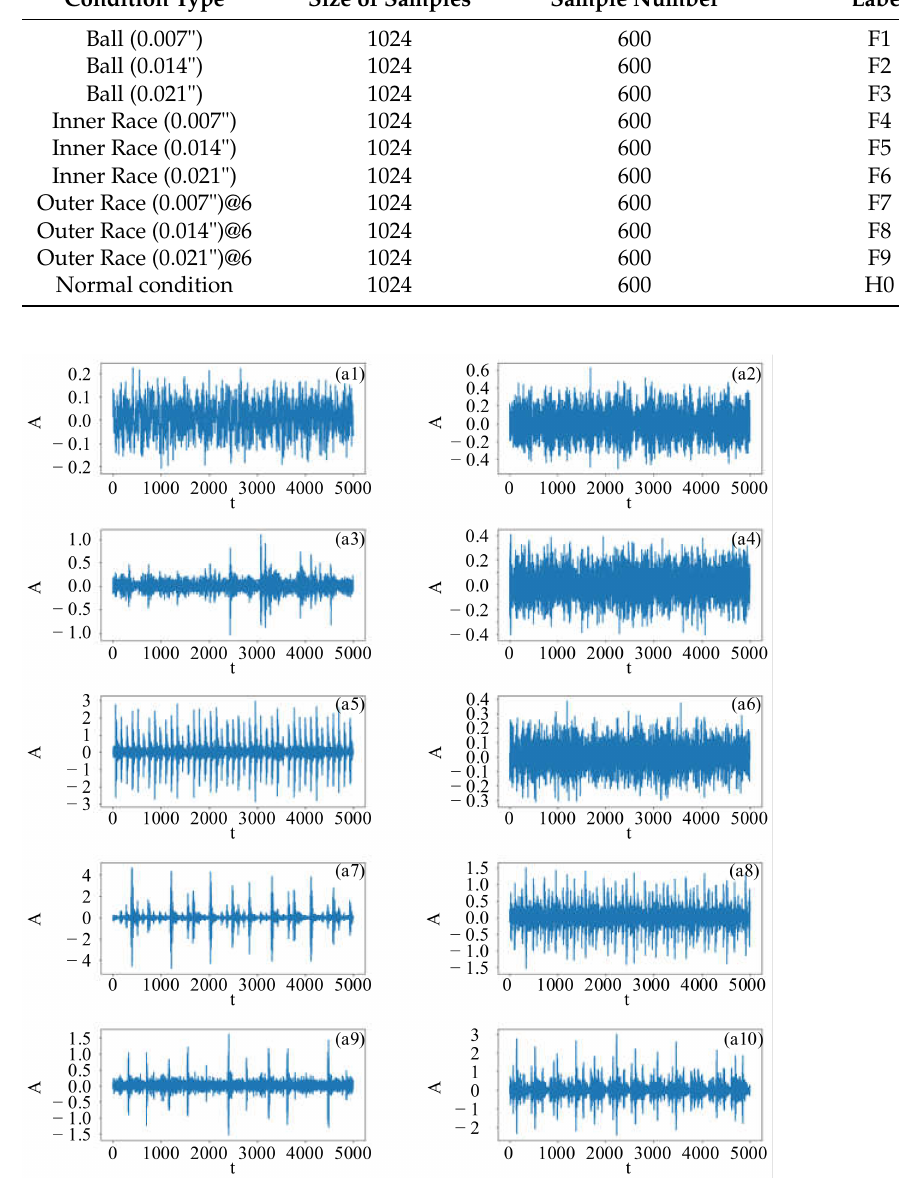
Figure 7. Vibration waveforms of rolling bearing in 10 states ( a1 ) Normal condition. ( a2 ) BF 0.007 inch. ( a3 ) BF 0.014 inch. ( a4 ) BF 0.021 inch. ( a5 ) OR 0.007 inch. ( a6 ) OR 0.014 inch. ( a7 ) OR 0.021 inch. ( a8 ) IR 0.007 inch. ( a9 ) IR 0.014 inch. ( a10 ) IR 0.021